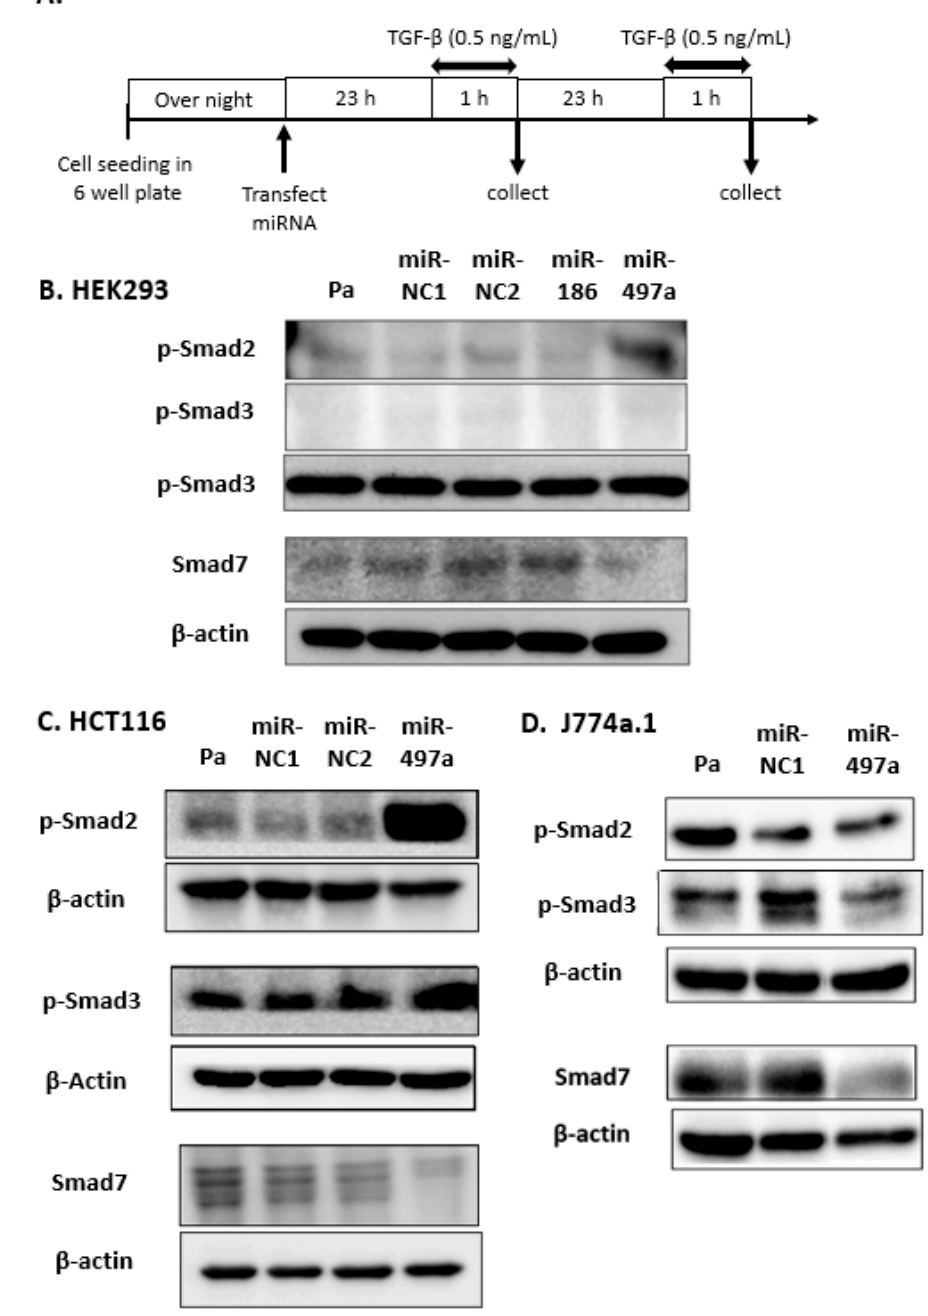
Figure 3. Western blot analyses for Smads in TGF- β /Smad signal pathway. ( A ) Experimental time schedule is shown here. ( B ) In HEK293cells, miR-497a-5p suppressed the expression of Smad 7 and increased the expression of p-Smad 2 48 h after transfection. The expression of p-Smad 3 was not detected. ( C ) In CRC line HCT116, miR-497a-5p suppressed the expression of Smad 7 and increased the expression of p-Smad 2 and p-Smad 3 24 h after transfection. ( D ) In mouse macrophage cell line J774a.1, miR-497a-5p suppressed the expression of Smad 7 miR-NC 48 h after transfection. The expressions of p-Smad 2 and p-Smad 3 were not affected